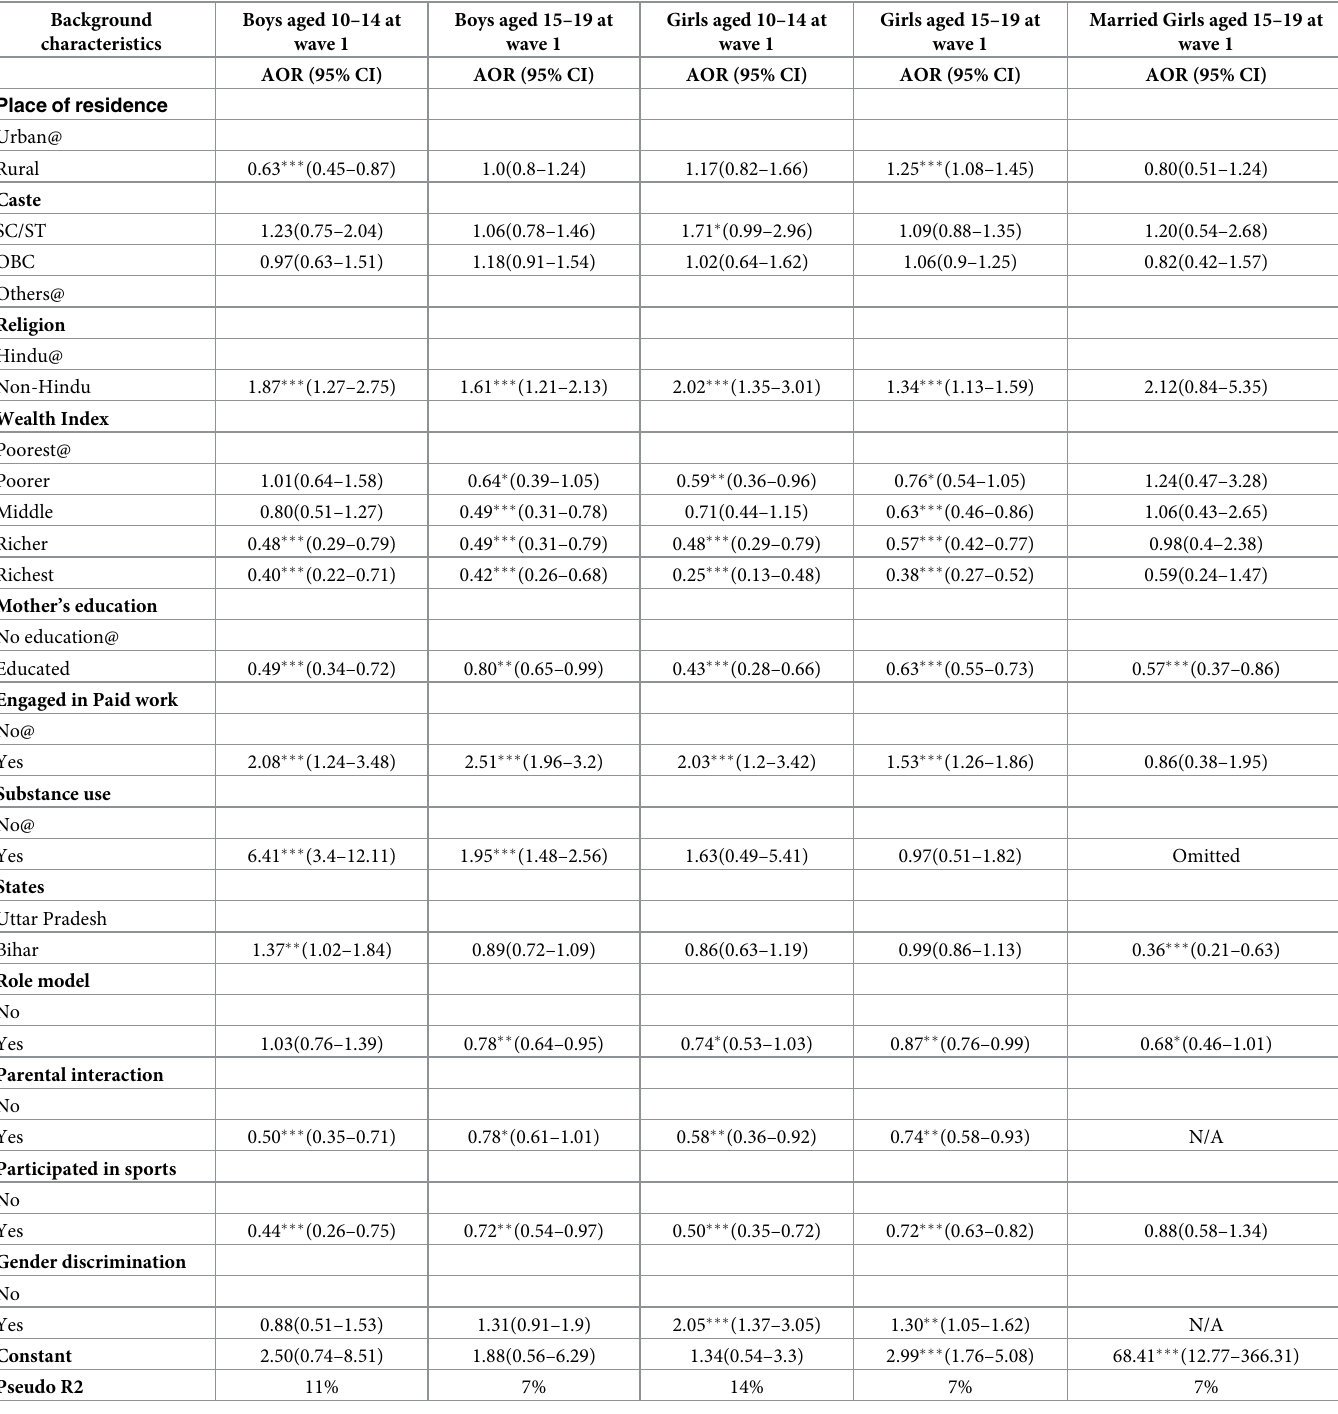
Table 3. Estimates from binary logistic regression analysis for school dropouts among adolescent boys and girls by background characteristics,